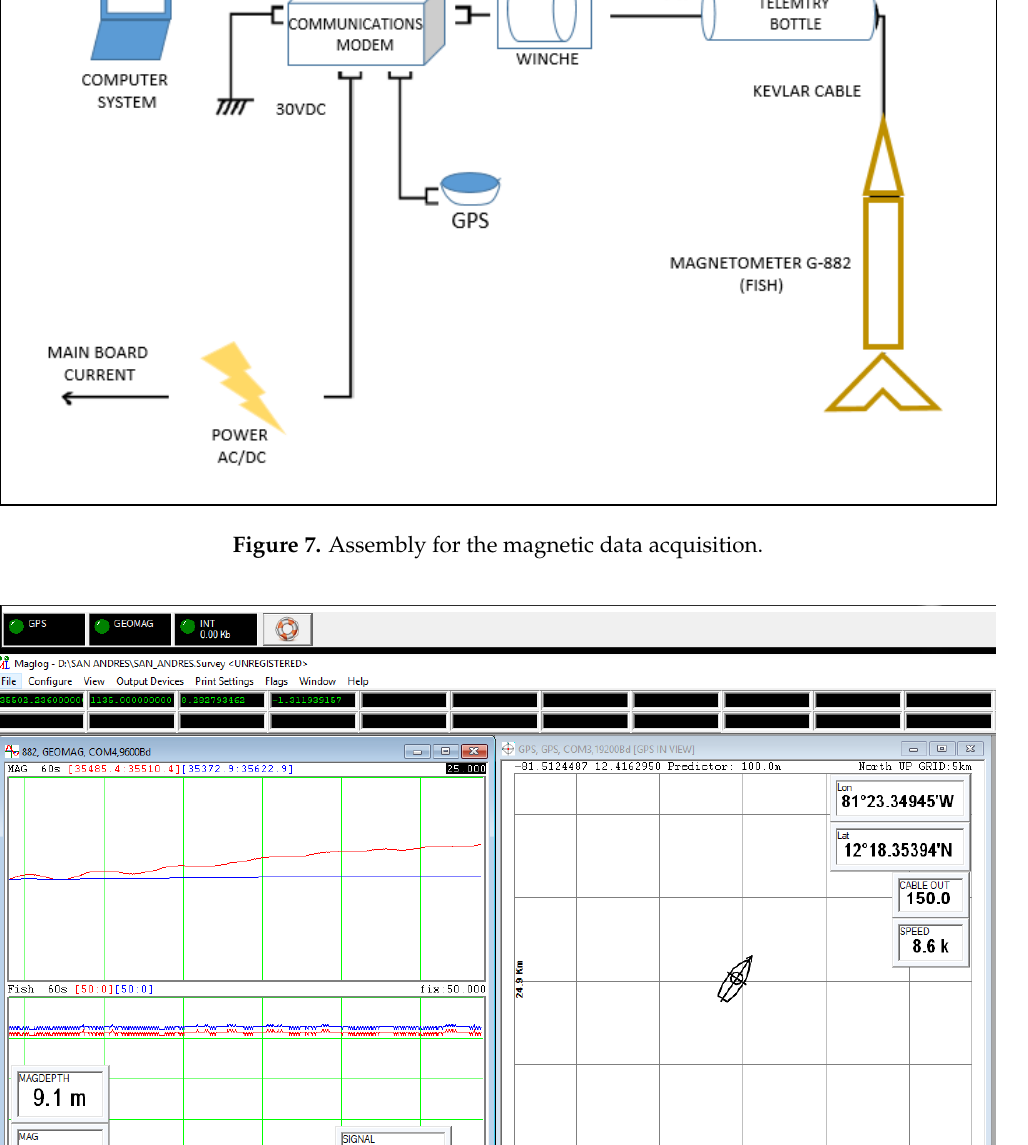
Figure 9. System of stern towing of the magnetometry equipment. Magnetic recording is only useful in straight transects, whereas data from the turns between profile and profile are not considered, as